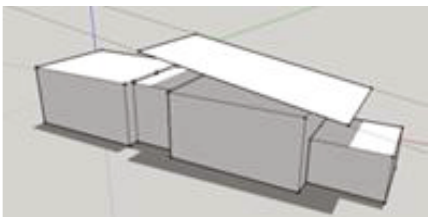
Figure 3: Flat roof form made of solar panels. Source: [4].